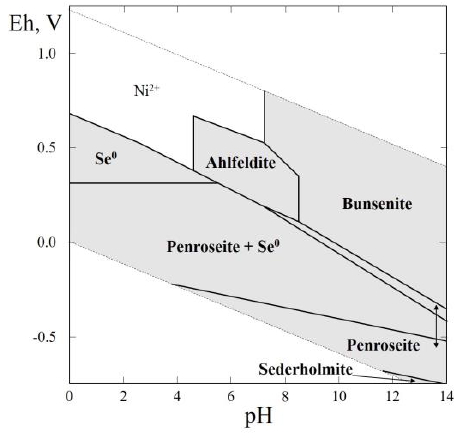
Figure 3. Eh–pH diagram of the system OHSeNi (Ni–Se–H 2 O) at 25 ◦ C and the activities of the components: a ΣSe = 10 − 4 , a ΣNi = 10 − 2 .